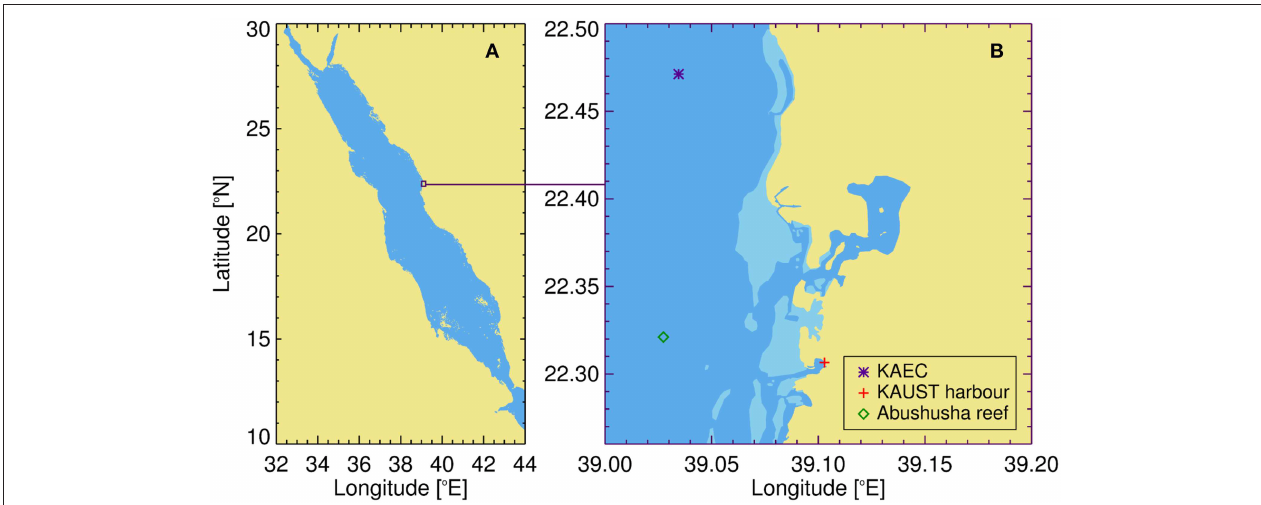
FIGURE 1 | Study site. (A) Location of the study site with respect to the broader Red Sea. (B) Study site near the coastal waters of Thuwal in the Kingdom of Saudi Arabia and the locations of the three datasets used in the study. KAEC refers to the King Abdullah Economic City and KAUST to the King Abdullah University for Science and